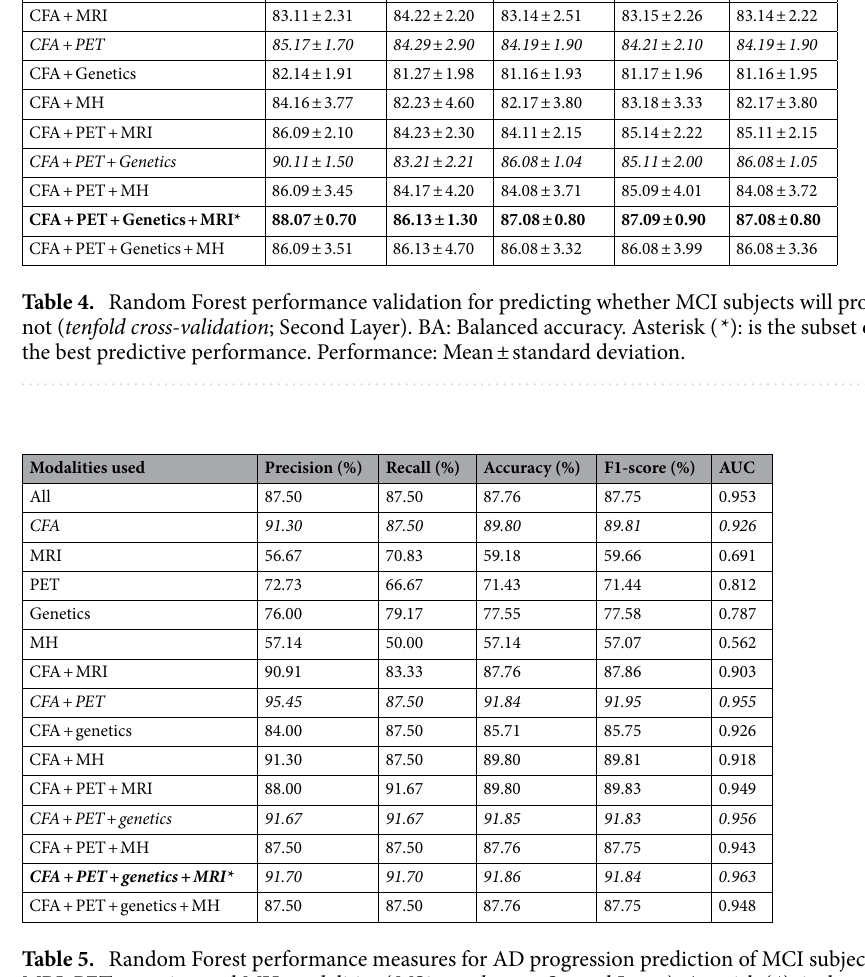
Table 5. Random Forest performance measures for AD progression prediction of MCI subjects based on CFA, MRI, PET, genetics, and MH modalities ( MS 2 test dataset ; Second Layer). Asterisk ( *): is the subset of features with the best predictive